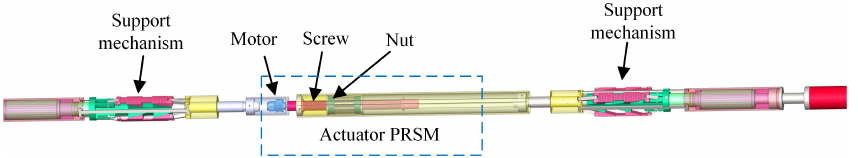
Figure 2. The presented downhole robot